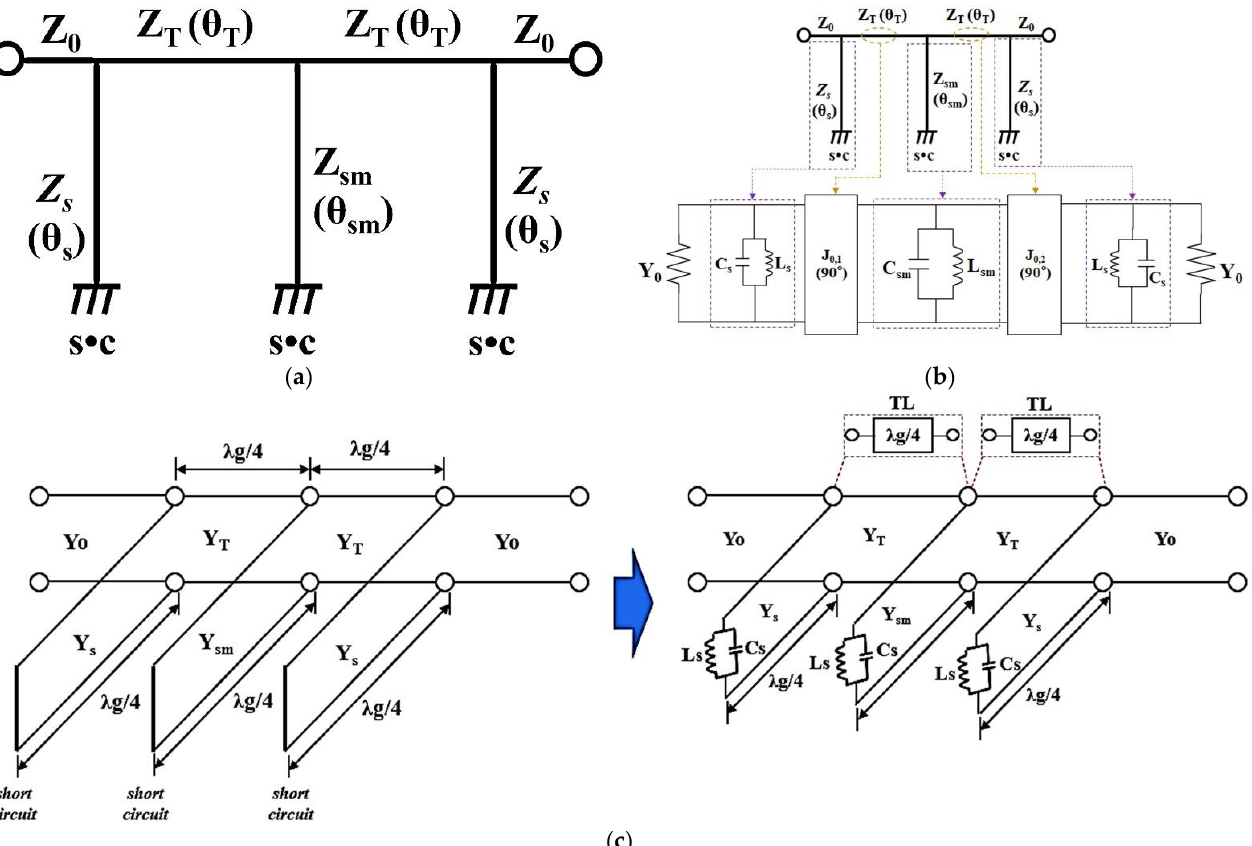
Figure 3. Equivalent circuit of a proposed BPF. ( a ) BPF. ( b ) J−inverter. ( c ) Detailed equivalent circuit.